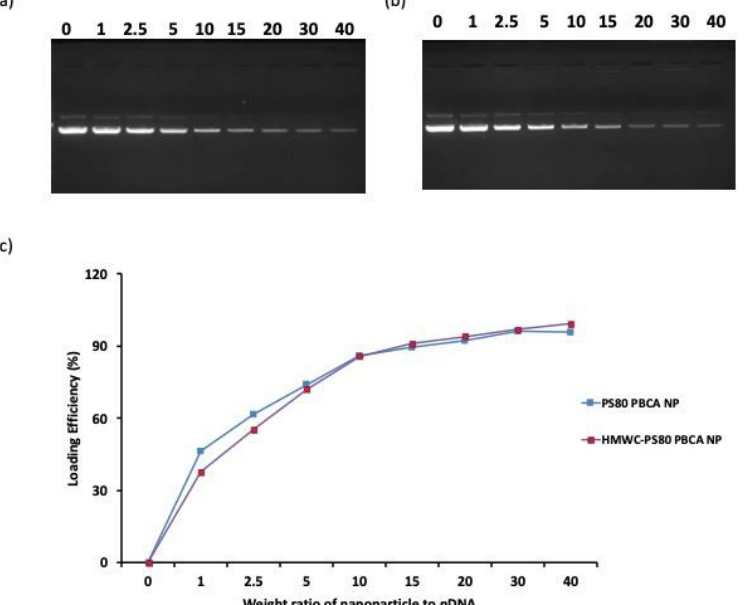
Figure 6. ( a ) Agarose gel electrophoresis of PS80 PBCA NP/BDNF p DNA and ( b ) HMWC-PS80 PBCA NP/BDNF p DNA polyplexes. A reduction in free BDNF p DNA was observed as the weight ratio of the nanoparticles to BDNF p DNA was increased. ( c ) The loading efficiency of BDNF p DNA on PS80 PBCA NP and HMWC-PS80 PBCA NP reached 90% at a weight ratio of 15 then plateaus.